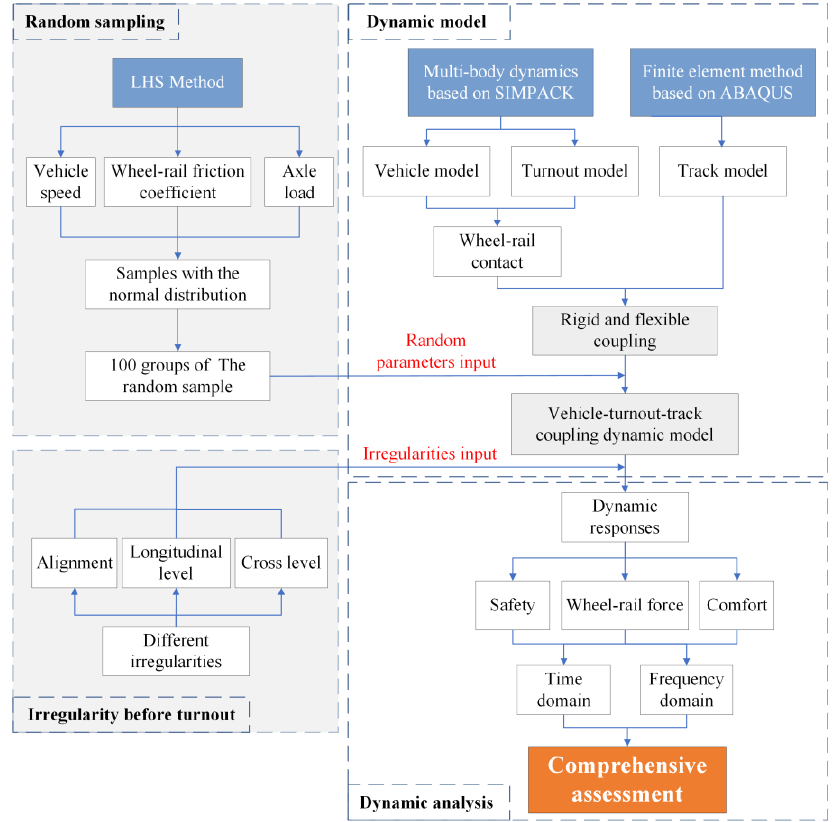
Figure 9. Calculation process based on the stochastic method.